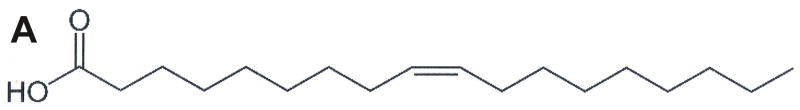
Fatty Acids. (A) Oleic Acid with one C=C bond (B) Linoleic Acid with two C=C bonds.